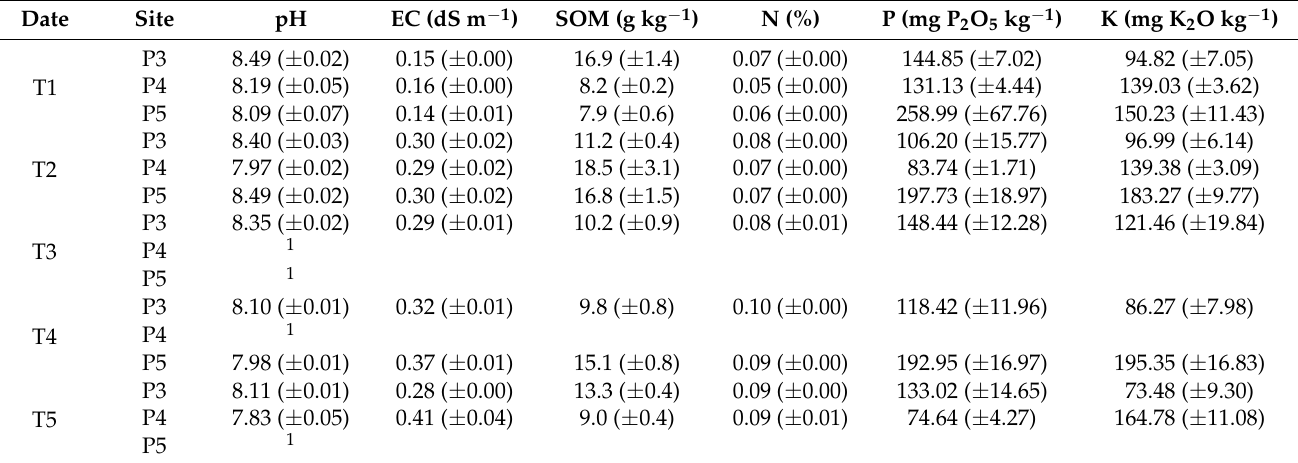
Table 5. Average values ( ± standard error) of soil chemical parameters in each site (P3 ( n = 9), P4 ( n = 9), P5 ( n = 12)), in the 20–40 cm layer, during the study (T1, T2, T3, T4, and T5 sampling